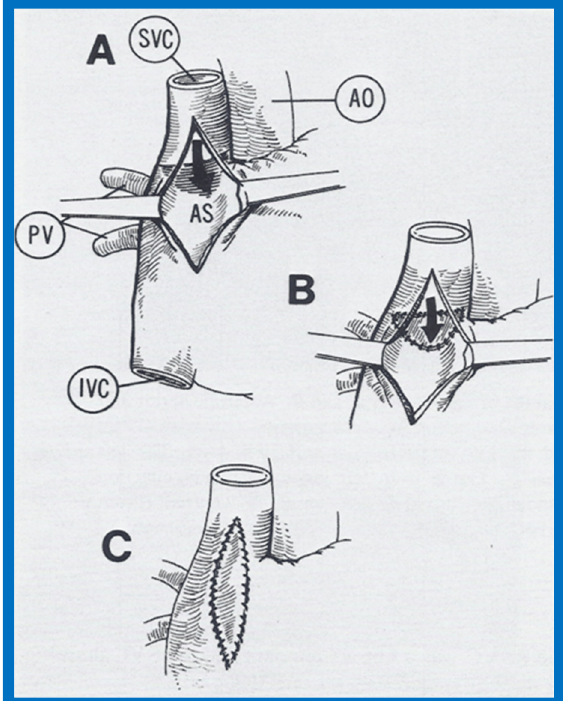
Figure 7. Artist’s portrayal of surgical correction of the superior vena cava (SVC) into the left atrium. ( A ) After incising the SVC, blood is seen going behind the atrial septum (AS) into the left atrium (solid arrow in A ). The shadowed area was resected. ( B ) A pericardial patch was sewn in such a way as to divert the SVC flow into the right atrium (solid arrow in B ). ( C ) A pericardia patch was placed to enlarge the SVC-right atrial junction. Ao, aorta; IVC, inferior vena cava; PV, pulmonary veins. Reproduced from Alpert B.S., Rao P.S., et al. [3].